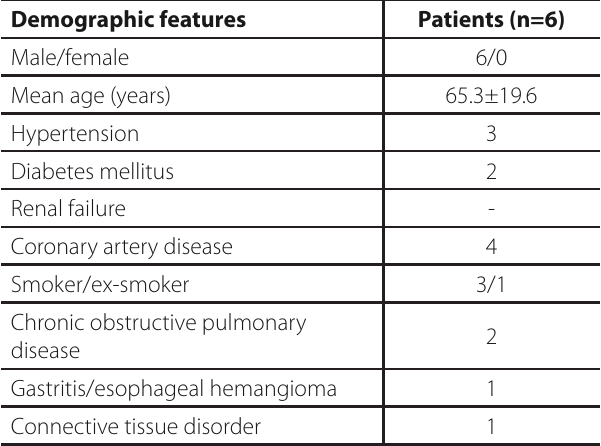
Table 1 . Demographic features of the